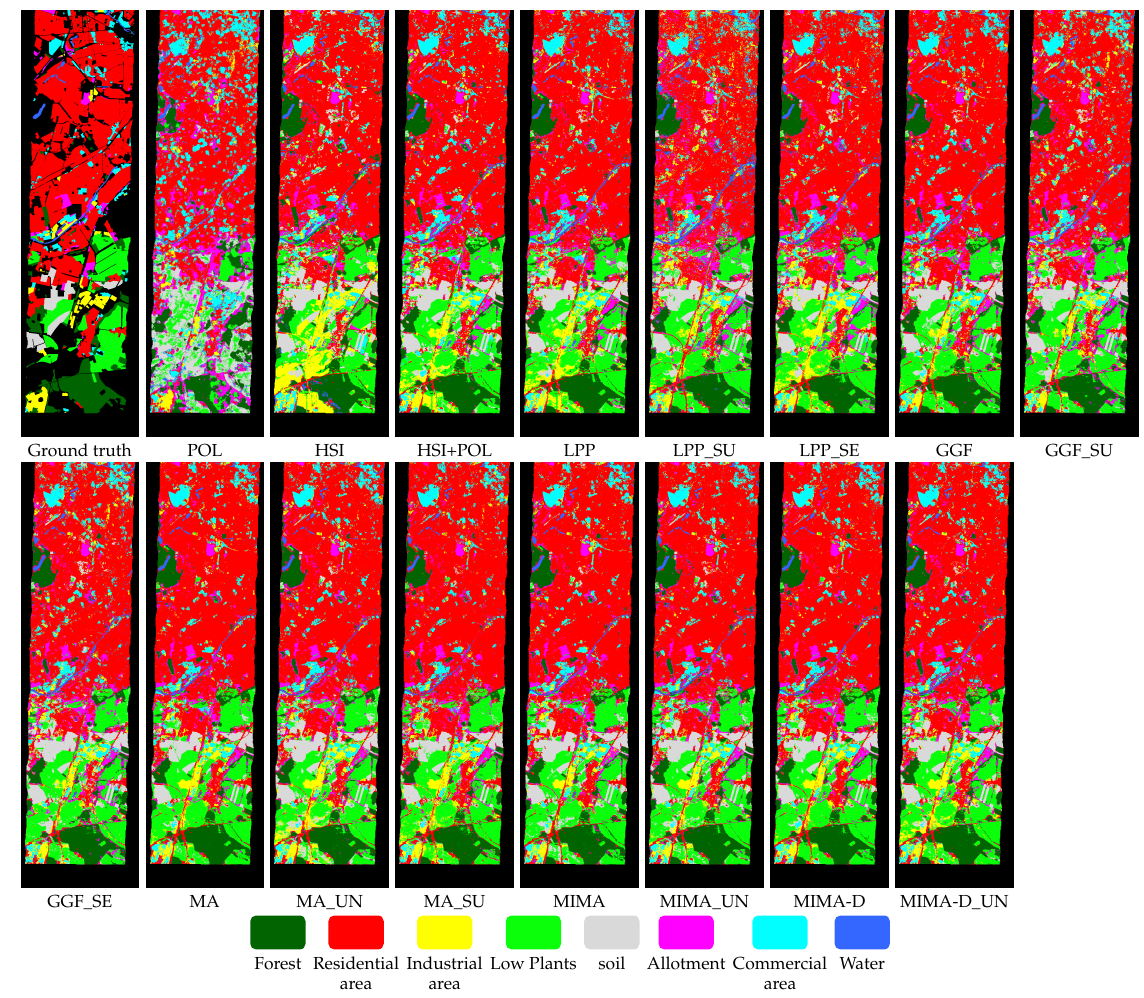
Figure 5. Visualization of the classification maps and the ground truth. The 16 classification maps are provided by applying CCF on fused data of the 16 algorithms, for the Berlin data set. Classification maps achieved by manifold alignment fusion methods are more accurate than the maps achieved by data alignment fusion